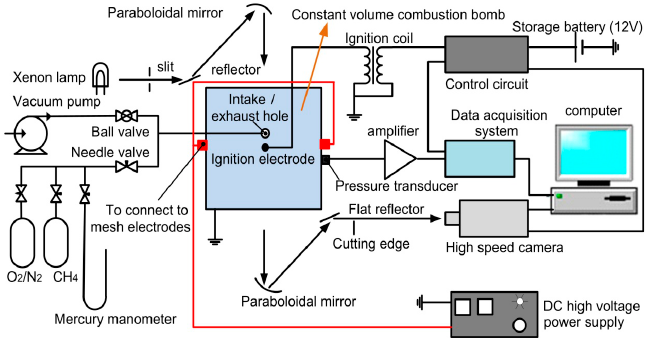
Figure 1. Schematic of the experimental setup.